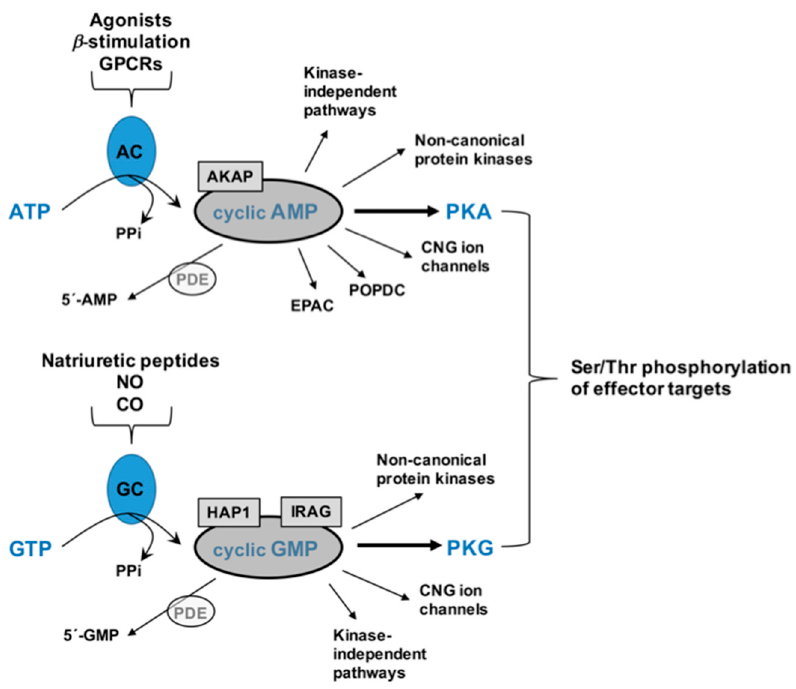
Figure 1. Schematic of cyclic adenosine monophosphate (cyclic AMP) and cyclic guanosine monophosphate (cyclic GMP) signaling. Following activation of adenylate cyclase (AC) by upstream processes including direct ligand agonism, B-adrenergic stimulation, or by stimulatory G protein-coupled receptors (GPCRs), adenosine triphosphate (ATP) is dephosphorylated to yield cyclic AMP and pyrophosphate (PPi). In similar fashion, stimulation of membrane-bound or soluble guanylate cyclase (GC) by natriuretic peptides or gaseous ligands nitric oxide (NO) and/or carbon monoxide (CO), GTP is dephosphorylated to yield cyclic GMP and PPi. Persistence of cyclic nucleotide signaling can be governed by the presence of scaffolding proteins including A-kinase anchoring protein for cyclic AMP or IP 3 receptor-associated cGMP kinase substrate (IRAG) and Huntingtin-associated protein 1 (HAP1) for cyclic GMP, and by degradation into inactive 5 ′ -monophosphates by a family of phosphodiesterases (PDEs). Cyclic AMP can operate through kinase-independent pathways, through binding to cyclic nucleotide-gated (CNG) ion channels or Popeye domain-containing proteins (POPDC), via exchange proteins directly activated by cyclic AMP (EPAC), through non-canonical protein kinases or by activation of PKA. In like manner, cyclic GMP can signal through kinase-independent pathways, by binding to CNG ion channels, through non-canonical protein kinases or via PKG. The predominant protein kinases for cyclic AMP and cyclic GMP, PKA, and PKG, can then stimulate Ser/Thr residues on many diverse downstream effector targets to help control normal physiology and homeostasis as well as wide-ranging pathophysiological processes in cardiac and vascular tissues.